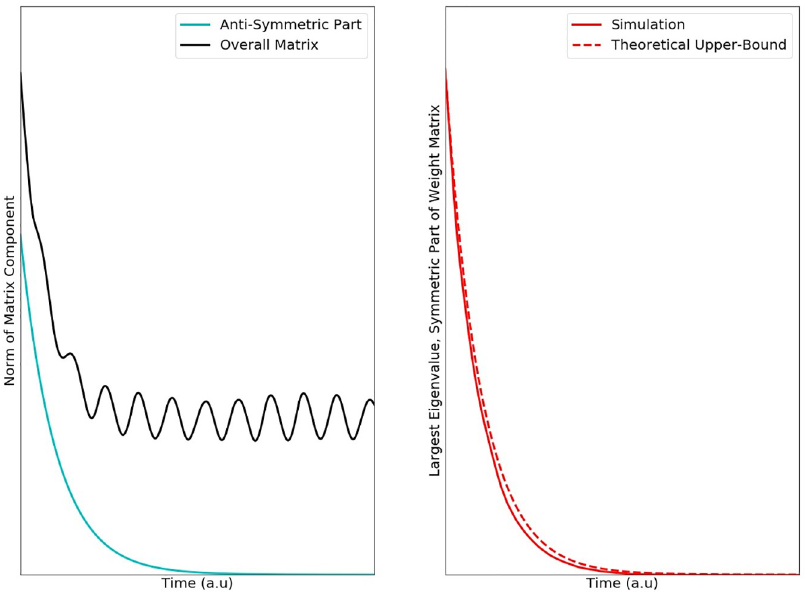
Fig 3. The anti-Hebbian plasticity pushes the weight matrix towards symmetry. (Left) Plotted are the spectral norms (largest singular value) of the overall weight matrix as well as the anti-symmetric part of that matrix. Since every square matrix can be uniquely decomposed as the sum of a symmetric and anti-symmetric component—0.5 � (W+W’) and 0.5 � (W-W‘), respectively—the teal curve decaying to zero implies that the matrix becomes symmetric. The black trace shows the spectral norm of the overall weight matrix. If this quantity does not decay to zero, it implies that not all the weights have decayed to zero. On the right, we plot the largest eigenvalue of the symmetric part of W. A prerequisite for overall contraction of the network is that this quantity be less than or equal to the ‘leak-rate’ of the individual neurons. The dotted line shows our theoretical upper bound for this quantity, and the solid line shows the actual value of taken from a simulation (see